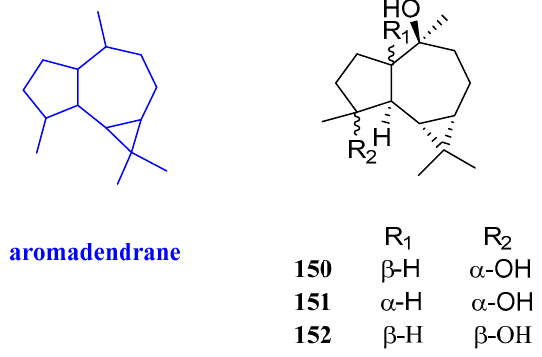
Figure 15. Structures of aromadendrane-type sesquiterpenoid 150 − 152 .